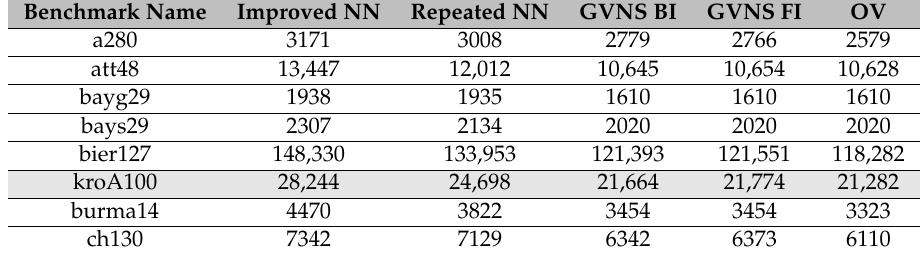
Table 2. The experimental results show that GVNS outperforms the improved and the repeated NN on TSP instances